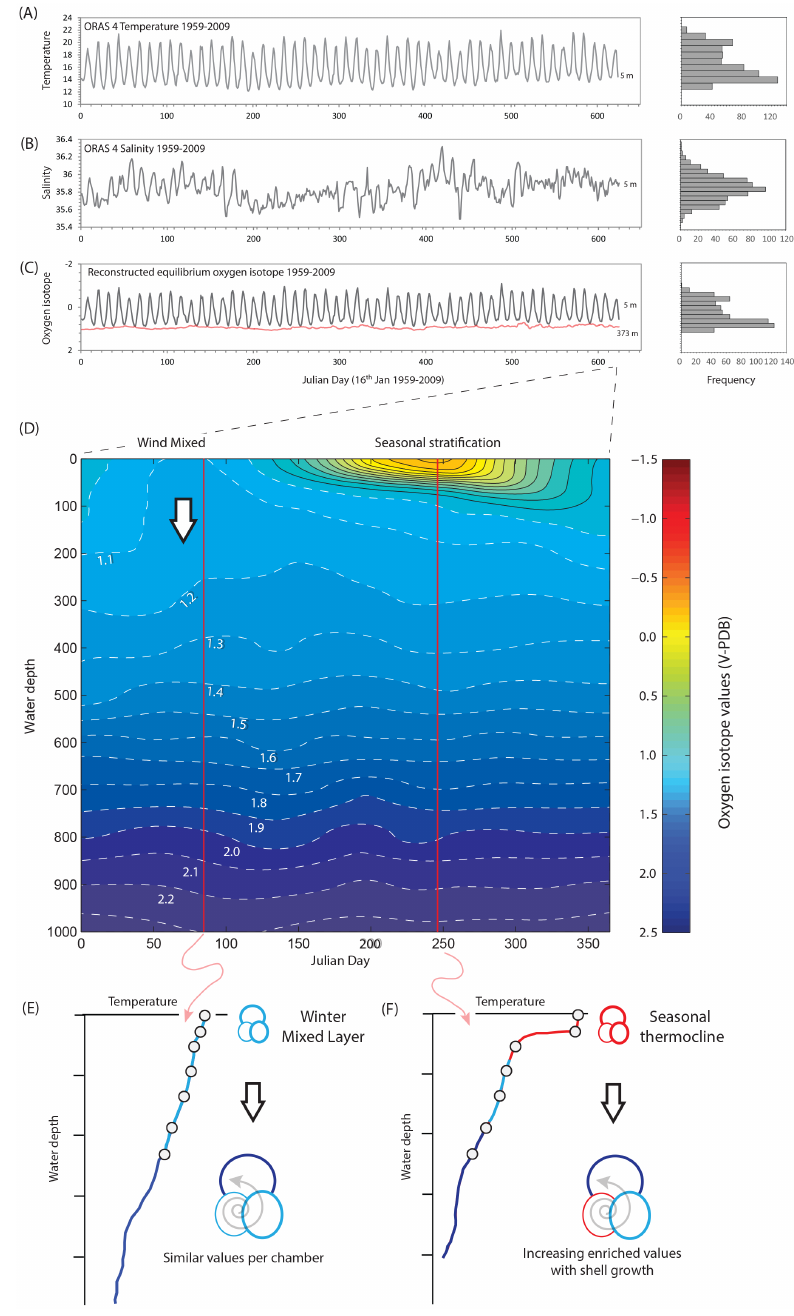
Figure 11. Schematic diagram of the key hydrological parameters at the core site and the insolation pattern for the studied interval. Ocean reanalysis data set of (a) monthly temperatures and (b) monthly salinity at 5m water depth for the years 1959–2009, excluding the warming since 2009 (Balmaseda et al., 2013). Using (a) and (b) , the (c) oxygen isotope equilibrium was calculated for 5m (black line), for reference (red line). (d) Oxygen isotope equilibrium ( δ 18 O eq ) representing the water structure plotted against time based upon “an average year” using values of World Ocean Atlas (WOA09) extracted from Ocean Data View (ODV). The main foraminiferal flux, as determined by the North Atlantic Bloom Experiment (NABE), the initial pilot study of the Joint Global Ocean Flux Study (JGOFS), lies between March and July. Maximum insolation occurs in June; however, the warmest month is later in September/October. Estimated depth habitat of G. bulloides , G. inflata and G. truncatulinoides is 100, 400 and 800m, respectively. Schematically, foraminifera that calcify in the winter mixed layer (e) are likely to record similar values for each successive chamber in comparison with those foraminifera that calcify in the seasonal thermocline (f)